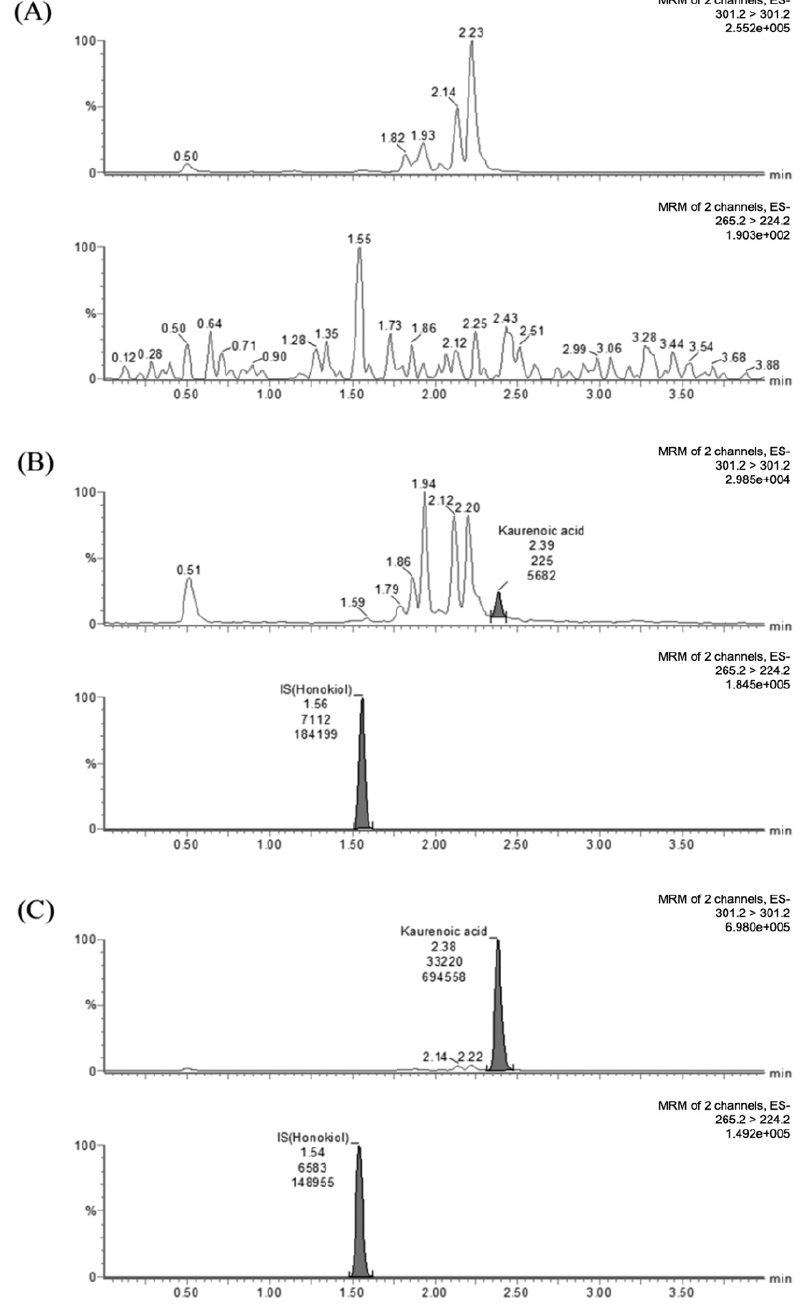
Figure 3. Representative Multiple reaction monitoring (MRM) chromatograms of KAU in human plasma samples. ( A ) Blank human plasma extract, ( B ) Human plasma sample extract containing KAU at LLOQ of 0.2 ng/mL and IS at 10 ng/mL, ( C ) human plasma sample extract (15.32 ng/mL for KAU) taken at 1 h after clinical oral dose administration of Araliae continentalis Radix extract powder (1.0054 g containing 1.147 mg KAU).